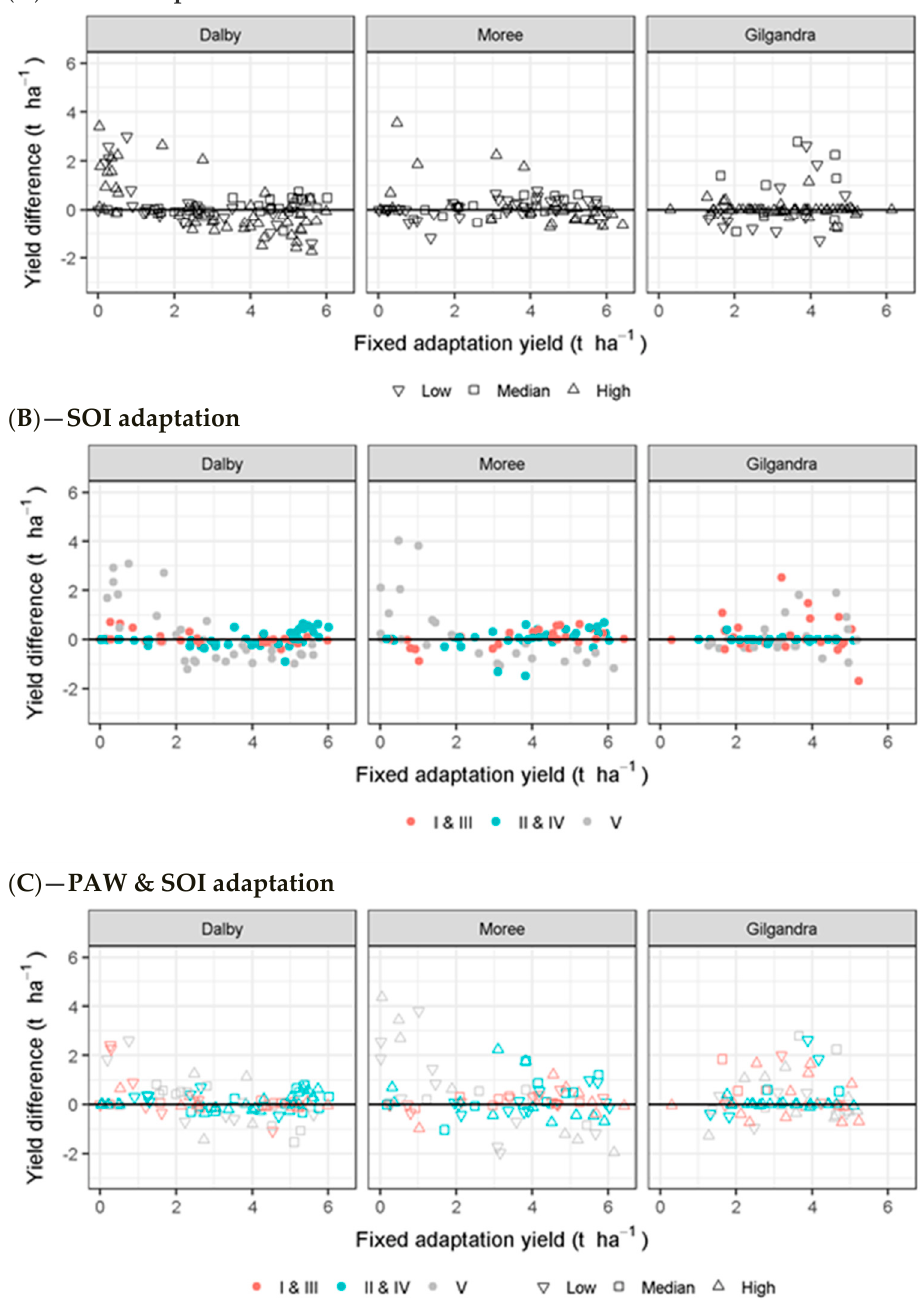
Figure 6. Yield advantage of tactical adaptation scenarios for ( A ) pre-sowing soil PAW (low, median and high), ( B ) SOI classes (I & III, II & IV and V), and ( C ) both PAW & SOI groups over fixed adaptation. The yield difference is calculated for each year. The fixed adaptation scenario corresponds to optimised genotype and management across all years. The three tactical adaptation scenarios correspond to optimised genotype and management for each PAW (plant available water) group and/or SOI class. SOI phases were determined in March–April, prior to sowing. See Figures S11–S13 for other sites.